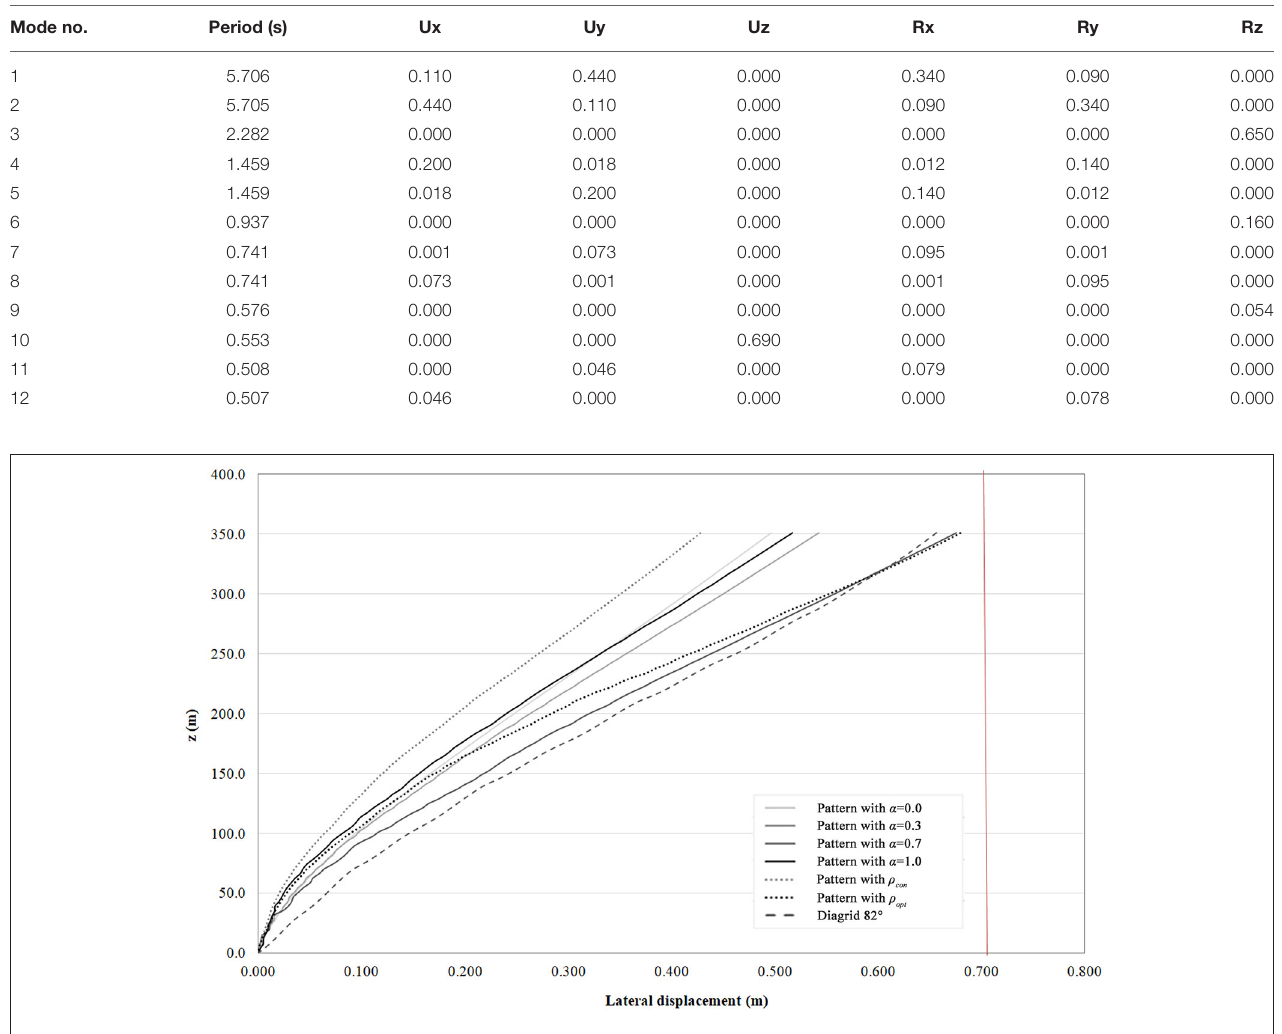
TABLE 3 | Results of the modal analysis for the model with optimized member cross-sections. Mode no.